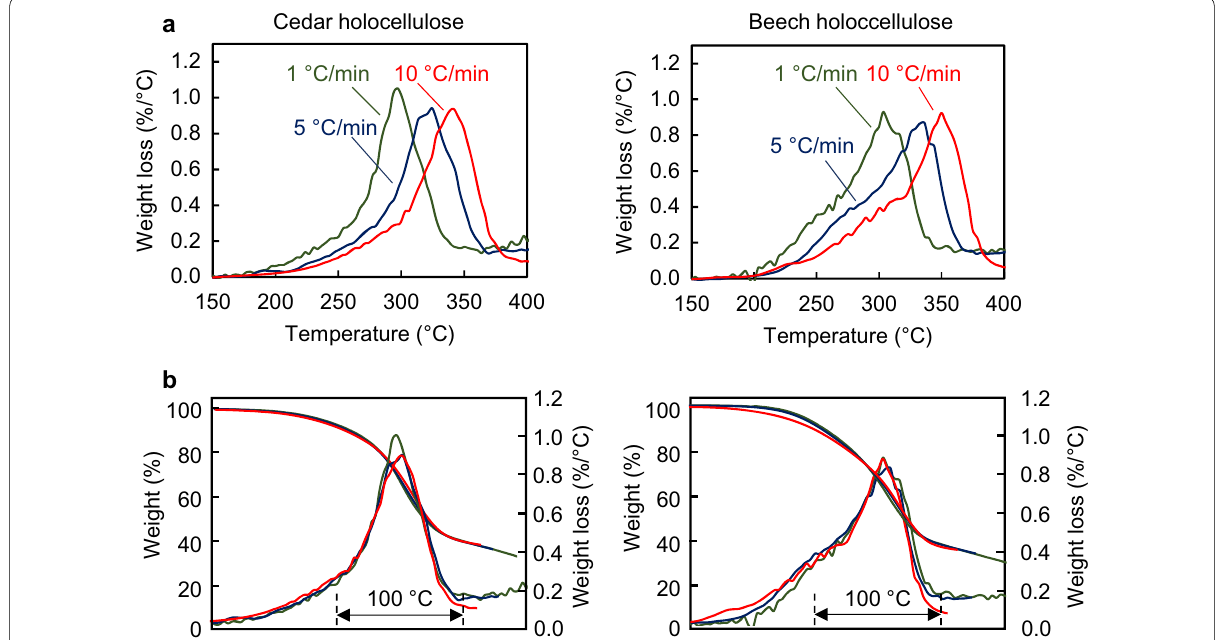
Fig. 9 TG/DTG curves of cedar and beech holocellulose samples redrawn with the unit of weight-loss rate changed from mg/min to mg/°C ( a ) and further moved with respect to the temperature axis so that the peaks of the DTG curves are aligned ( b